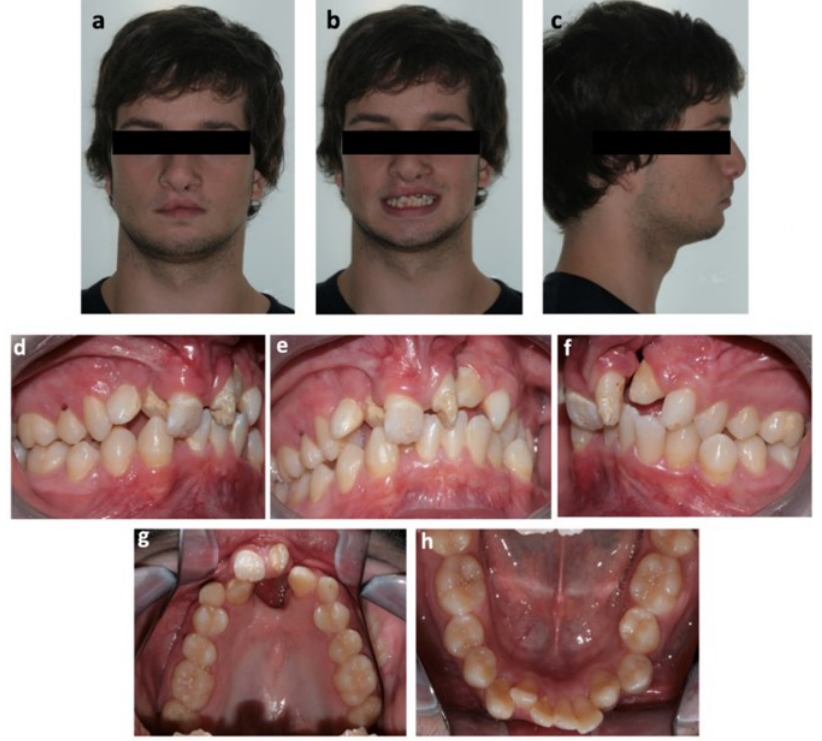
Figure 1. Pretreatment photographs: extraoral ( a ) frontal view; ( b ) frontal view with smile; ( c ) profile) and intraoral ( d ) right side; ( e ) frontal; ( f ) left side; ( g ) superior arch; ( h ) inferior arch.